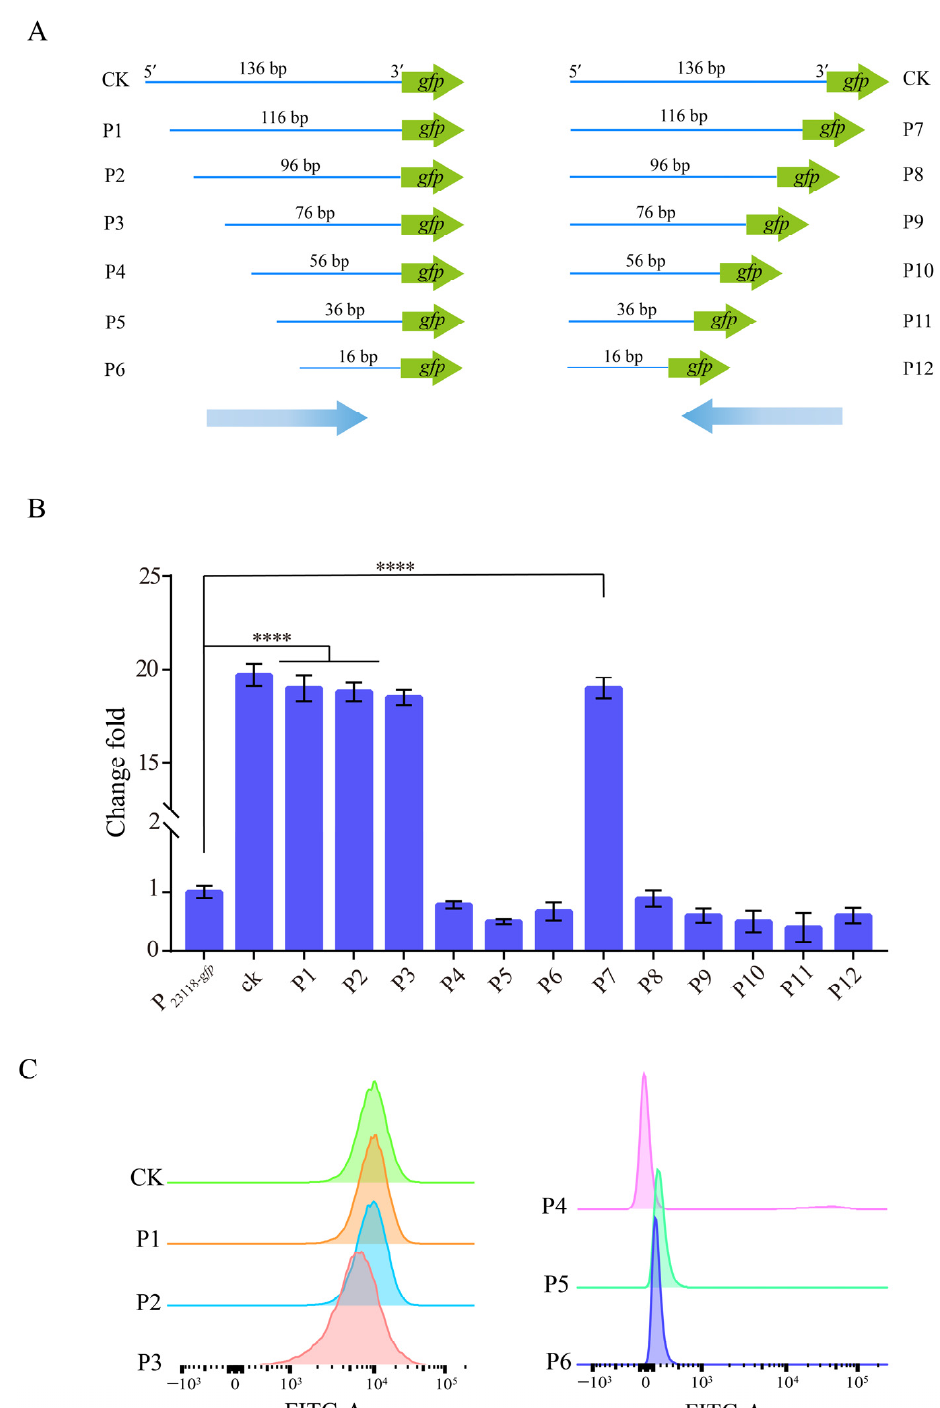
Figure 2. Characterization and identification of the constitutive promoters from B. subtilis 168. ( A ) Shortening and characterization of the screened promoter sequence from B. subtilis 168. ( B ) Fluores- cence variation range of each truncated promoter using GFP as the reporter gene. ( C ) FACS analysis of fluorescence intensity of truncated promoters P1 to P6. For B, error bars indicate standard devia- tions. One-way analysis of variance (ANOVA) was used to examine the mean differences between the data groups. **** p < 0.001.